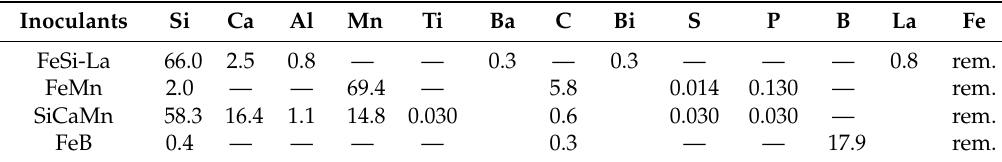
Table 4. Chemical composition of the inoculants used (% wt.).